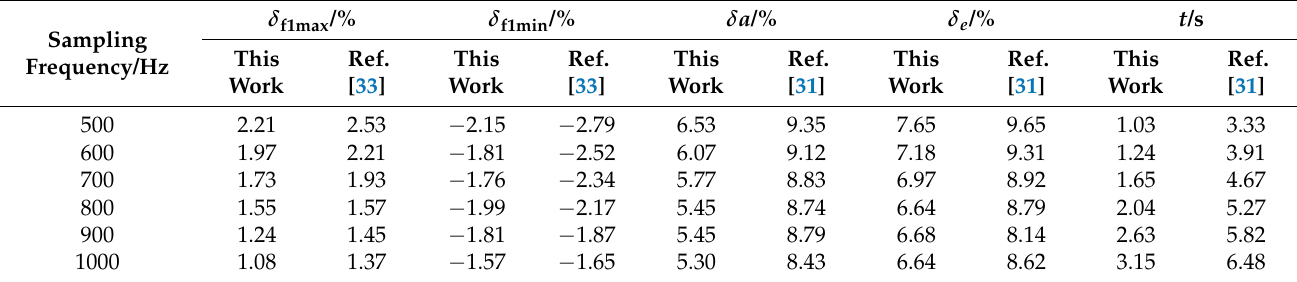
Table 4. Test results of the physical prototype of the sensor.